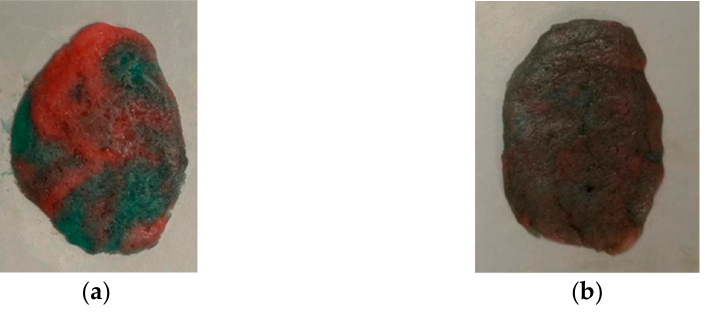
Figure 4. ( a ) chewing gum chewed by a patient with poor chewing efficiency. ( b ) Chewing gum chewed by a patient with excellent chewing